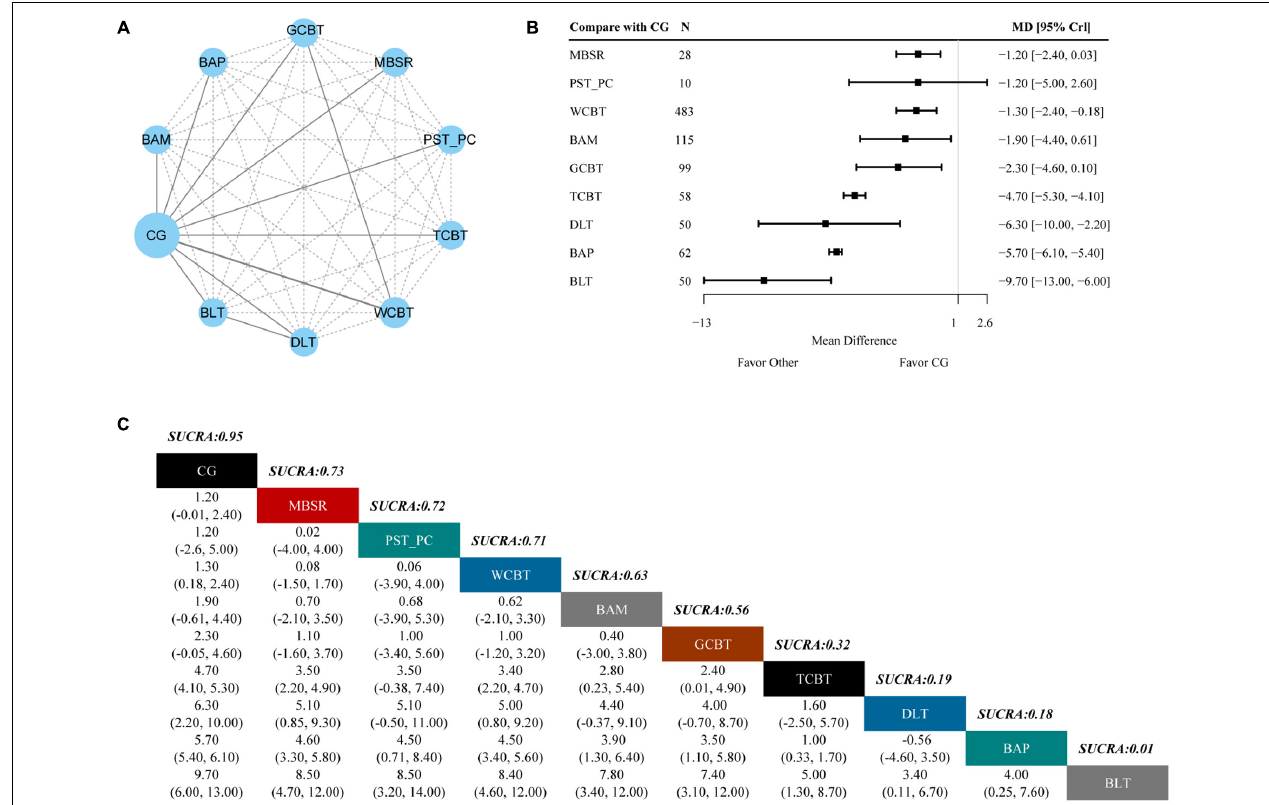
FIGURE 3 | Results of the network meta-analysis for BDI. (A) Network geometry of eligible comparisons for BDI. (B) Forest plot of the network meta-analysis compared with control group. (C) Ranking of each intervention based on the SUCRA values and the league table for the relative effects of all treatments. BLT, bright light therapy; DLT, dim light therapy; BAP, behavioral activation program; TCBT, telephone-based cognitive behavioral treatment; GCBT, group cognitive behavioral treatment; BAM, behavioral activation with mindfulness; WCBT, web-based cognitive behavioral treatment; PST-PC, problem solving therapy for primary care; MBSR, mindfulness-based stress reduction; CG, control group; SUCRA, surface under the cumulative ranking curve; MD, weighted mean difference; CrI, credible